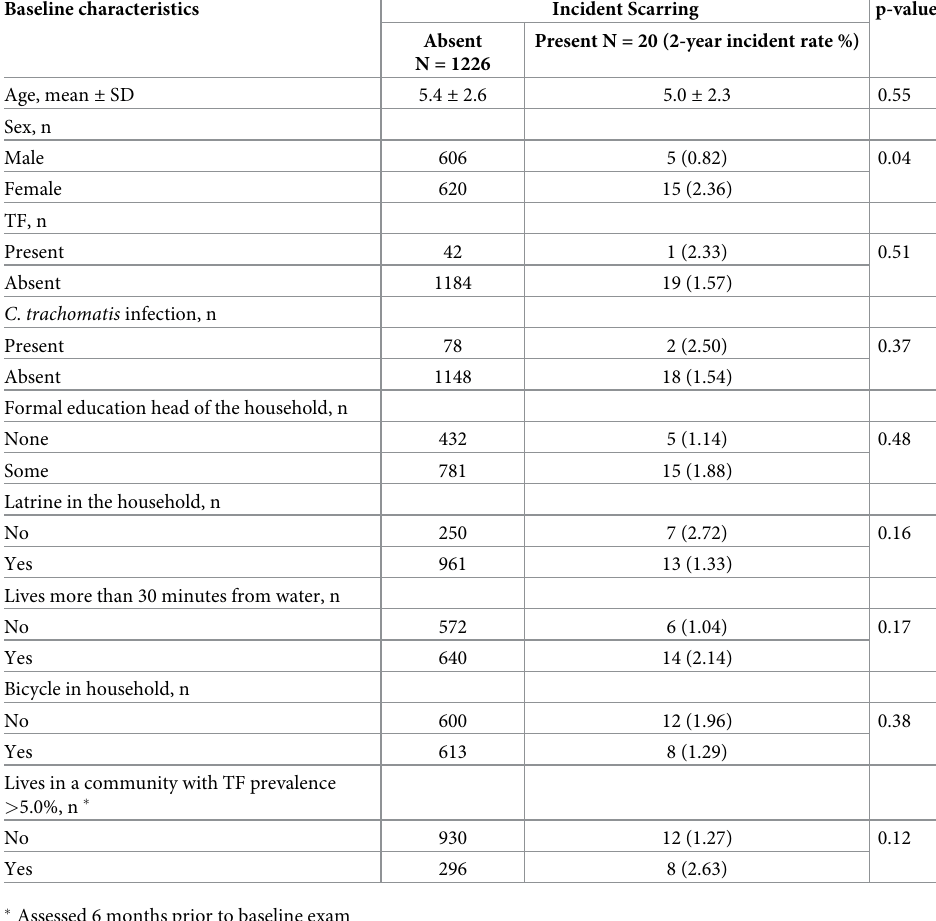
Table 3. Baseline characteristics by incident scarring at 2-year follow-up. Baseline